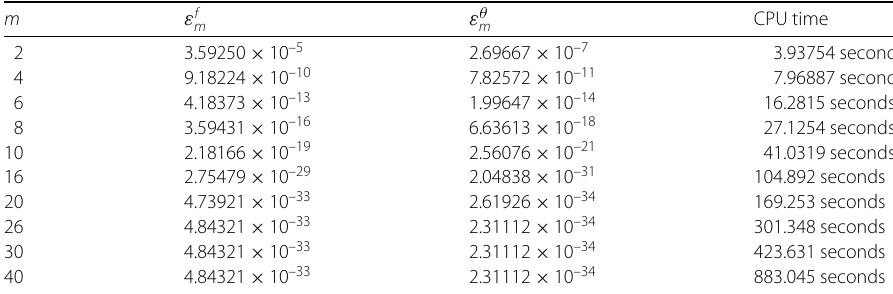
Table 2 Individual averaged squared residual errors using optimal values of auxiliary parameters m ε f m ε θ m CPU time